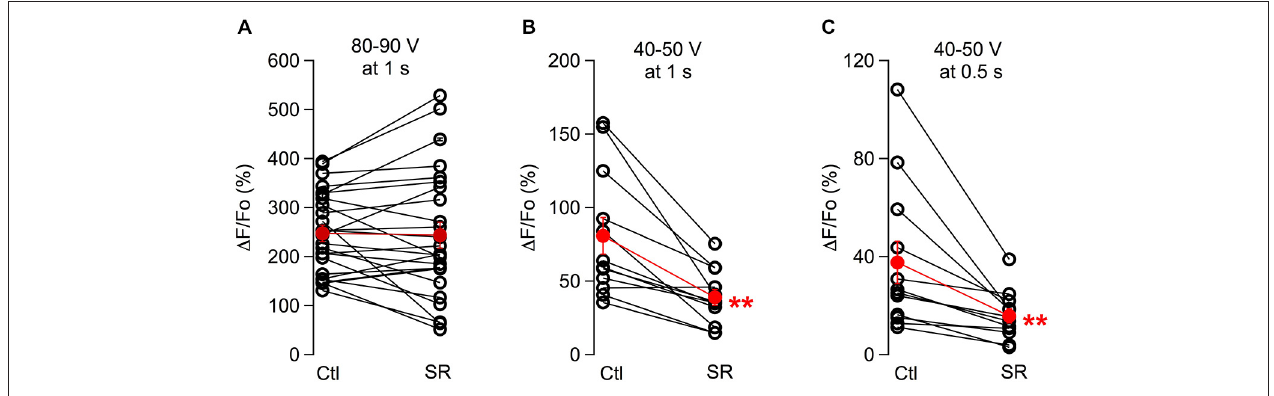
0.5 s. For all cases, values for each soma were averaged over 3 consecutive runs for the control period and for the same number of runs taken 30–50 min after drug application. Open symbols represent individual somata and red dots the corresponding average; error bars are SEM. ** p ≤